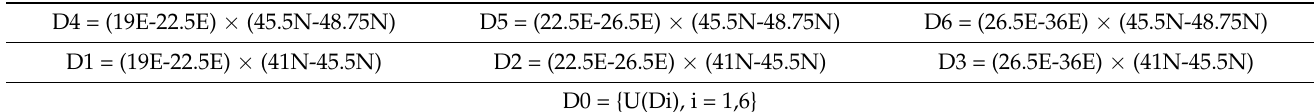
Table 2. Tracks’ target regions.